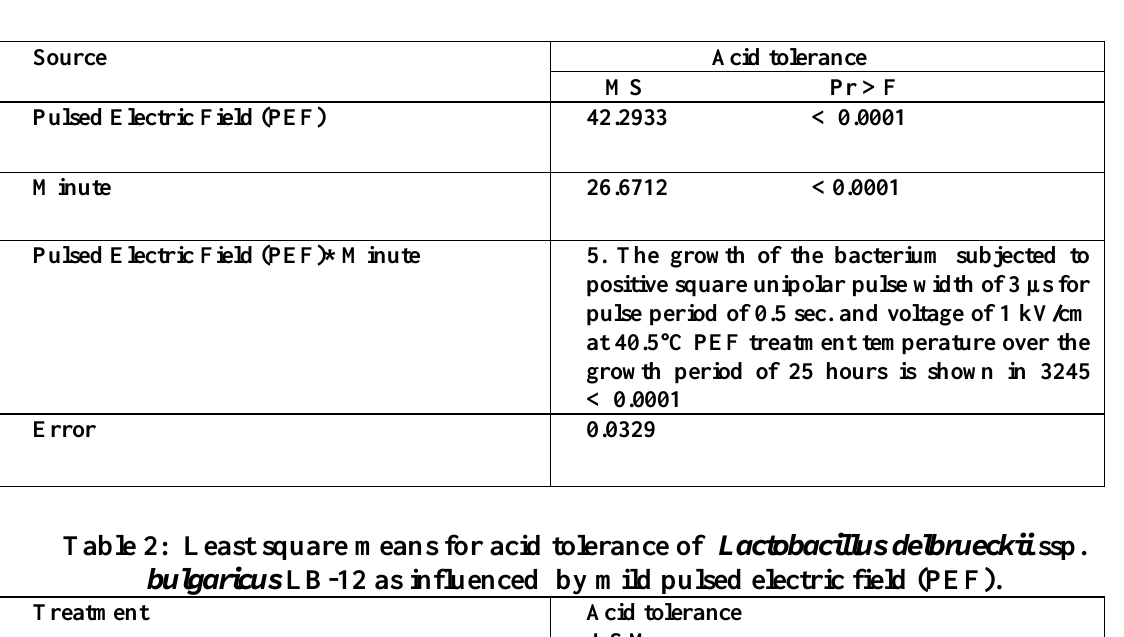
Table 1: Mean square (MS) and Pr > F of mild pulsed electric field (PEF), minute and their interaction for acid tolerance of Lactobacillus delbrueckii spp. bulgaricus LB-12.